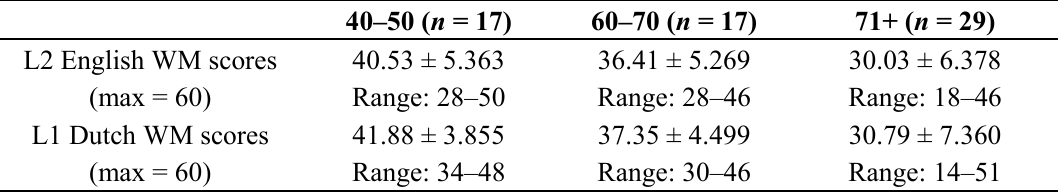
Table 3. Mean WM scores (and SDs) on the L1 and L2 Reading Span Tasks, split per age